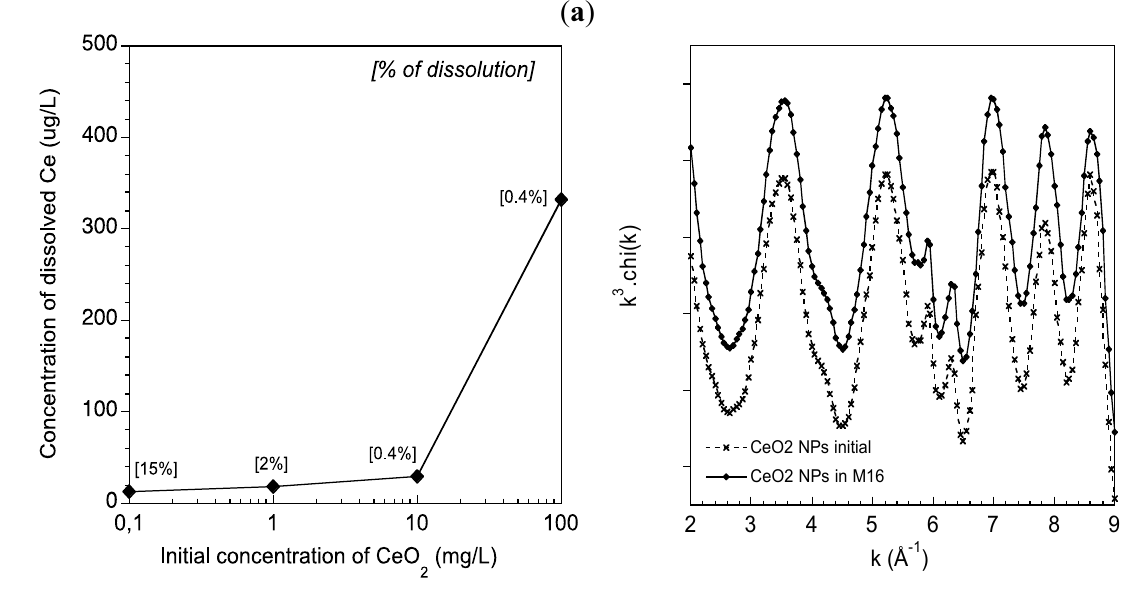
O ENPs in the M16 medium. Distribution of the e 2 O ENPs in their stock suspension and after 2 h in the e 2 O ENPs after 2 h in the abiotic M16 determined by e 2 O ENPs in M16. EXAFS at the C e 2